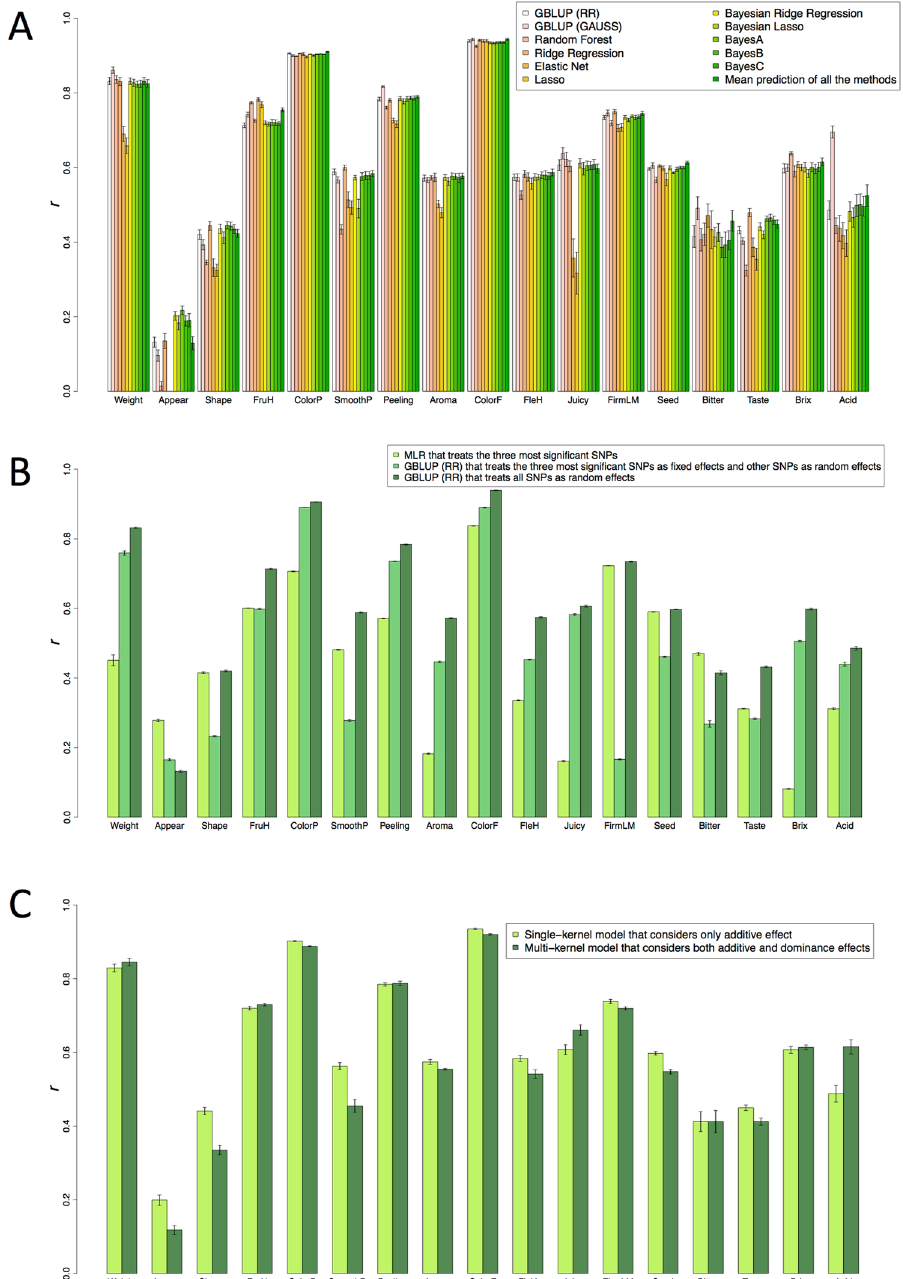
Figure 4. Comparison of prediction models using the parental population. Prediction accuracy was measured as the Pearson’s correlation coefficient ( r ) between predicted genotypic values and phenotypic values. ( A ) Twelve methods were tested. RR: ridge kernel regression, GAUSS: Gaussian kernel regression. ( B ) Regression models were built based on the results of GWAS. The three SNPs that showed high –log 10 ( p ) values in GWAS (red points in Supplementary Fig. S5) were selected. MLR: Multiple Leaner Regression. ( C ) Prediction models that considered only additive or both additive and dominance effects were